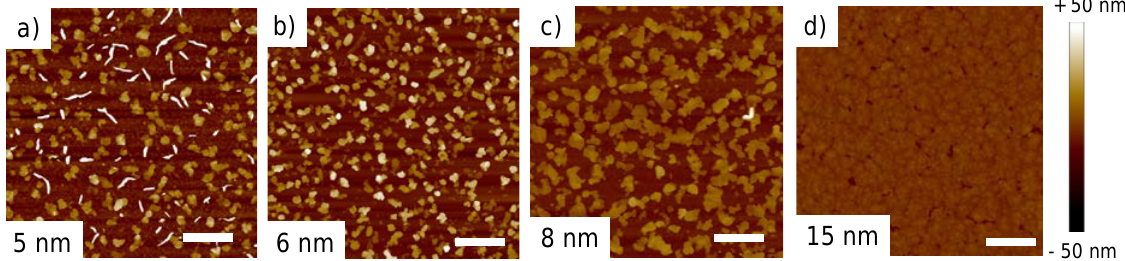
Figure 3. AFM height images of DNTT thin films of thicknesses of ( a ) 5 nm, ( b ) 6 nm, ( c ) 8 nm and ( d ) 15 nm. Scale bar: 2 μm.